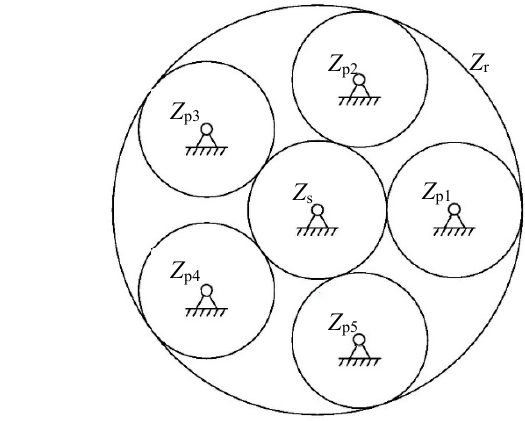
Figure 2. The mechanism motion diagram of herringbone tooth star gear train.